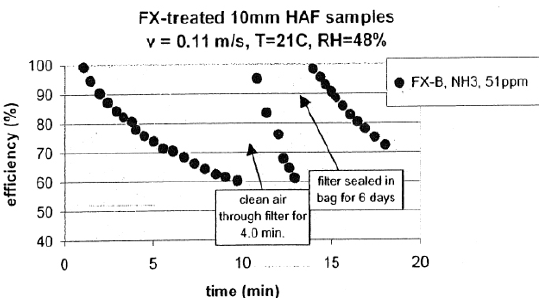
Figure 7. “Recharging” of FX-B sample (Sample B). from FX-B 3